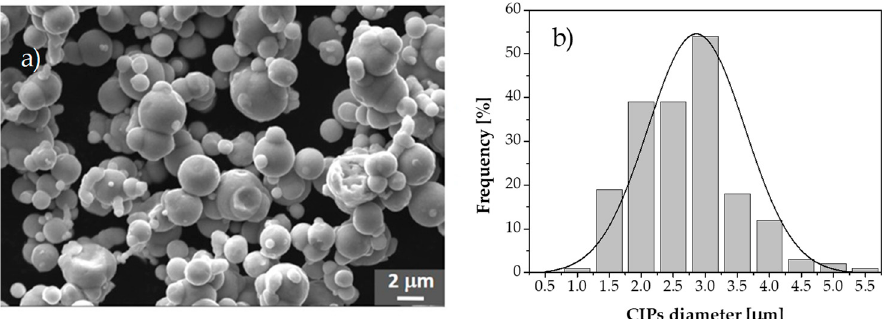
Figure 8. ( a ) Image obtained from SEM equipment. Notice the spherical like-form of the CIPs used to reinforce the PDMS elastomer. ( b ) Based on the Digimizer 4.6.1 software, the particle size distribution obtained from several measurements is in the range of 1–5.5 µm with and average diameter of about 3 µm, which agrees with the supplier technical specifications.